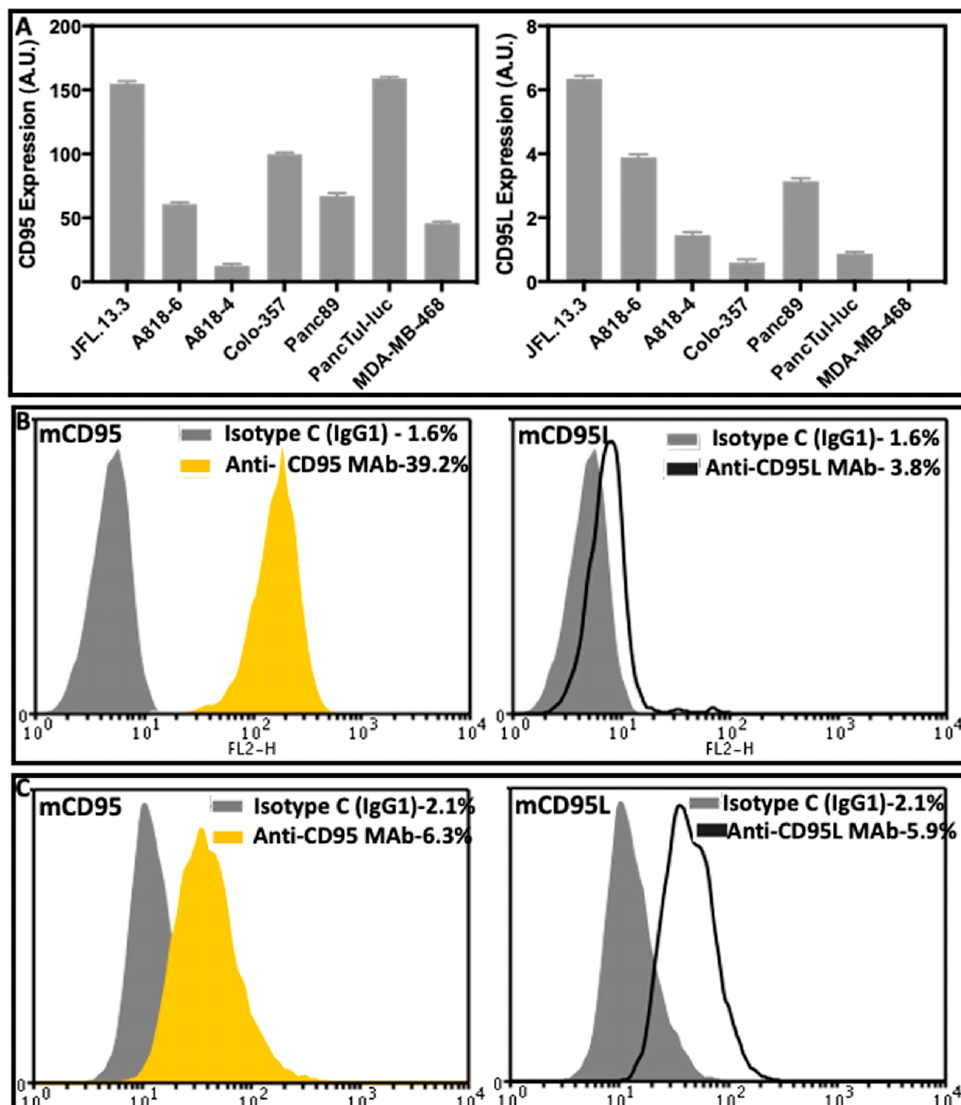
quantitative gene expression analyses in five different PDAC cell lines (A818-6, A818-4, Colo-357, Panc89 and PancTuI-luc) and a T-lymphocyte cell line, JFL.13.3 (positive control for CD95L), and a breast cancer cell line, MDA-MB-468 (negative control for CD95L), by means of a PerfectProbe ® PCR assay. Both CD95 and CD95L mRNA were detected in all five PDAC cell lines as well as in JFL.13.3. MDA-MB-468 cells showed moderate CD95-, but no CD95L expression. We observed a differential expression pattern for both CD95 and CD95L in the PDAC cell lines. However, comparing the expression levels of our two main model cell lines A818-4 and PancTuI-luc, we noted that the expression of CD95 was high in PancTuI-luc compared to A818-4 while the pattern got reverse for the expression of CD95L (Figure 1A).